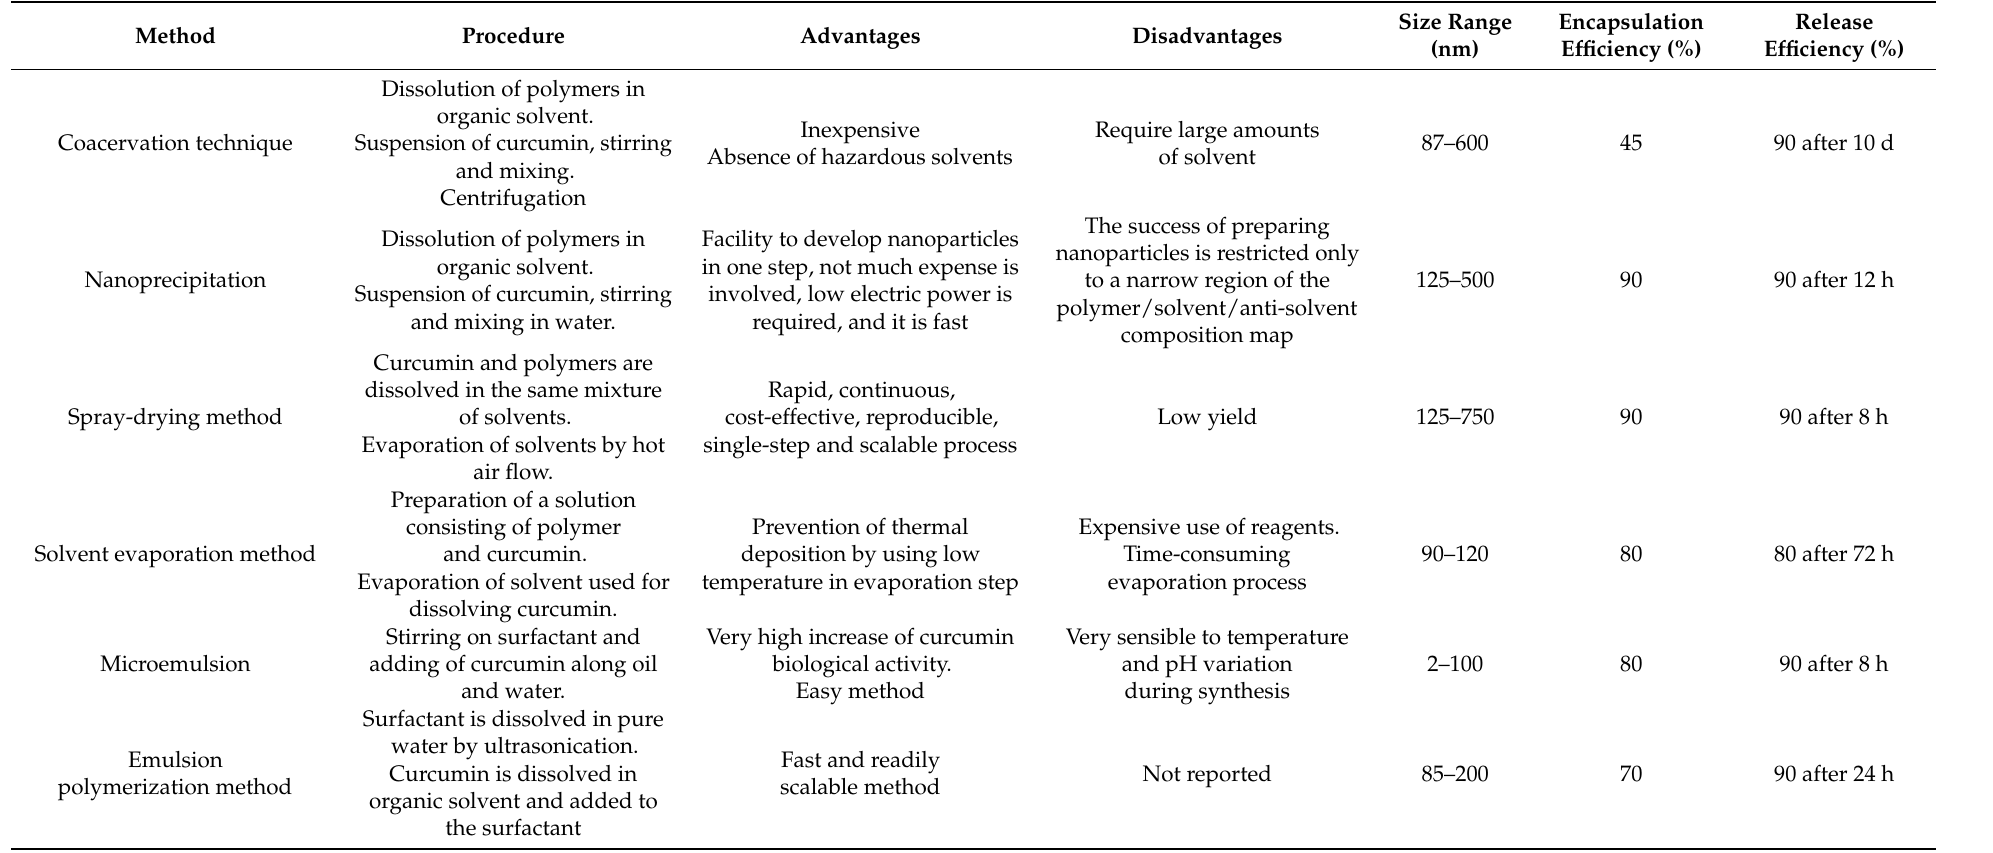
Table 5. Main procedures for obtaining nanocurcumin formulations, their advantages, disadvantages and main features, obtained by summarizing data reported in